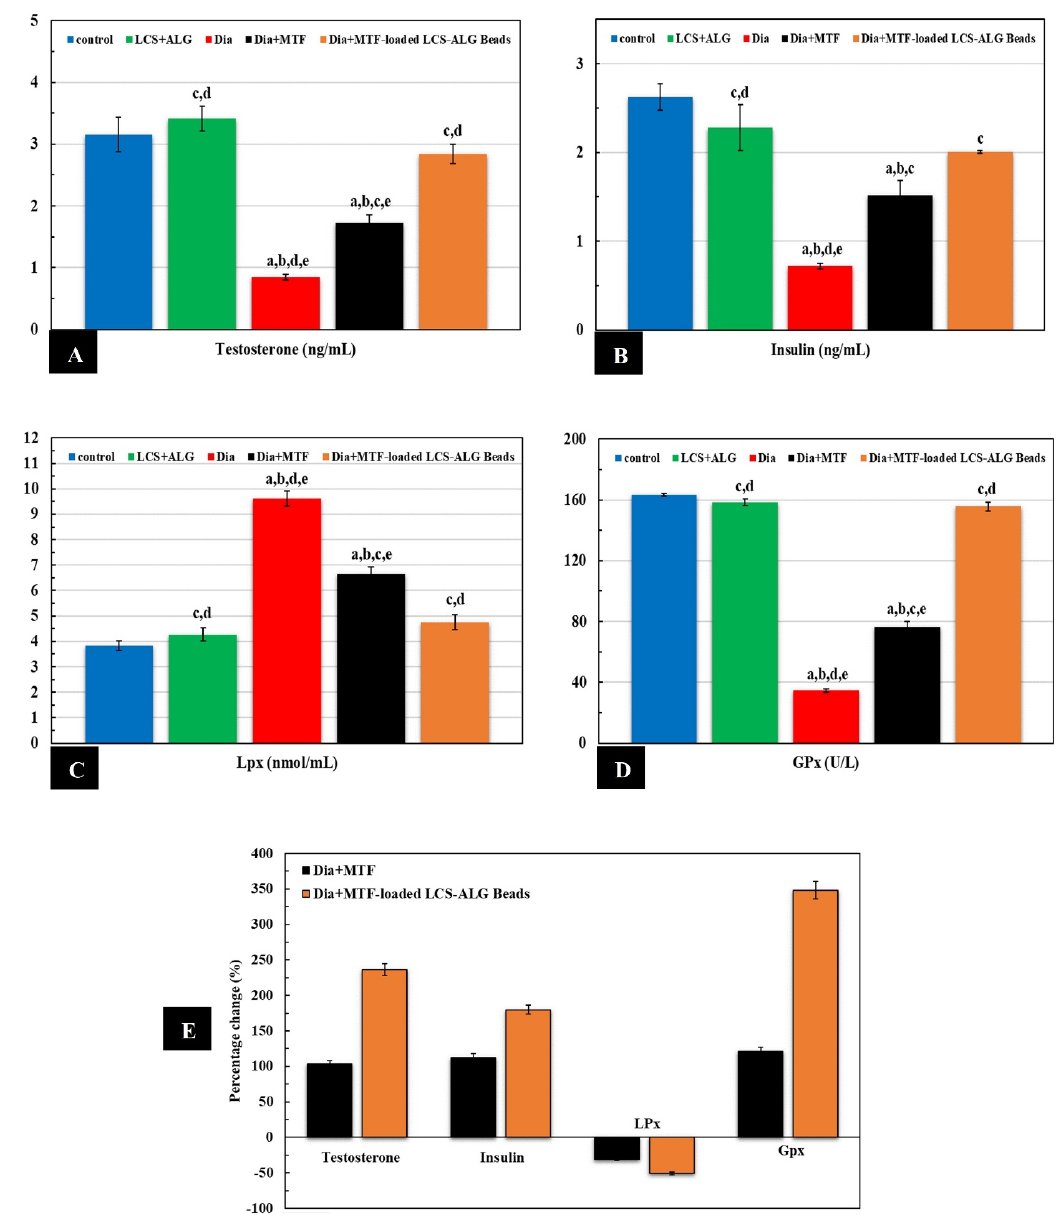
Figure 13. ( A ) Levels of testosterone, ( B ) insulin, ( C ) LPx, and ( D ) GPx at the end of the treatment period (29 days). Data are presented as (mean ± SD, n = 6), significance at p < 0.05. a : significantly different when compared to control, b : significantly different when compared to LCS + ALG, c : significantly different when compared to Dia, d : significantly different when compared to compared to Dia + MTF and e : significantly different when compared to MTF-loaded LCS-ALG bead group. ( E ) Percentage changes in biochemical parameters examined in Dia + MTF and MTF-loaded LCS-ALG bead groups relative to Dia